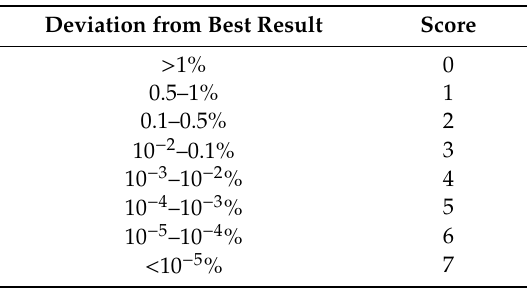
Table 4. Score for di ff erent deviations from best result.